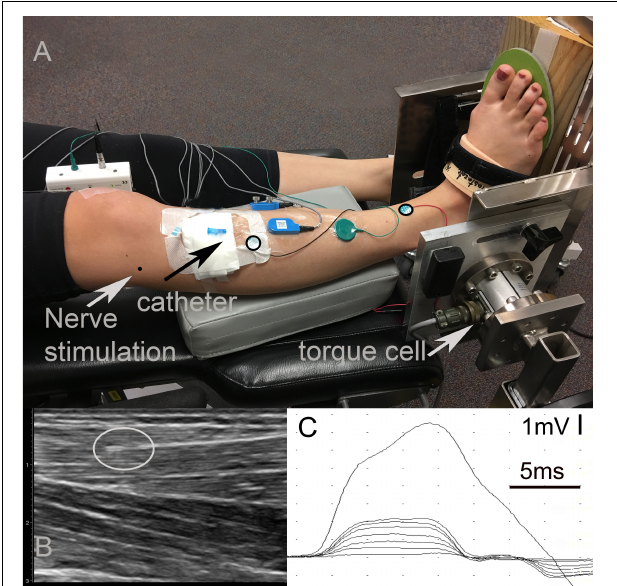
FIGURE 1 | Experimental data collection. (A) Setup: The right foot of the participant strapped into a custom torque measurement system. The center of the torque cell was aligned with the ankle axis using a laser pointer whose light was in line with the lateral malleolus. A wooden wedge with an angle of 20 ◦ was placed underneath the foot in order to promote the optimal line of action of the tibialis anterior (TA) muscle. Black circles on the TA show the locations of the anode and cathode of the CMAP surface recording electrodes. The black arrow shows the entry of the catheter. The tip of the sensor is below the black circled electrode inside the muscle. The gray arrow shows the entry of the fine-wire needed for fibular nerve stimulation. Note that data collected from surface EMG electrodes and fine-wire EMG electrodes shown in the picture were not included into this study. (B) Ultrasound image of the TA identifying the location of the intramuscular pressure (IMP). The gray circle shows the tip of the IMP sensor. (C) Time dependent tracing of the compound muscle action potential (CMAP) for different levels of fibular nerve